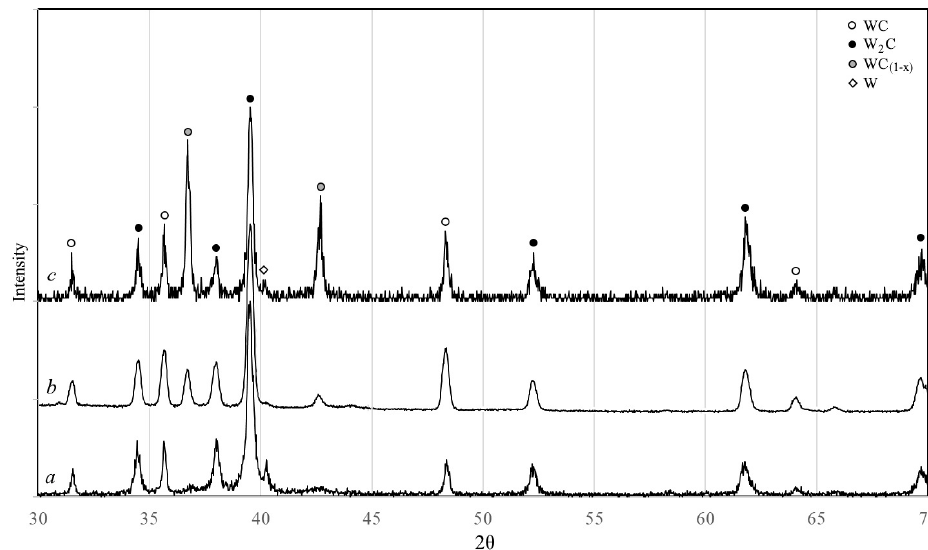
Figure 8. XRD patterns of initial W-C-Co nanopowder ( a ) and W-C-Co powder spheroidized at different plasma enthalpy: ( b ) 2.8 kW ∙ h/m 3 , ( c ) 4.8 kW ∙ h/m 3 .